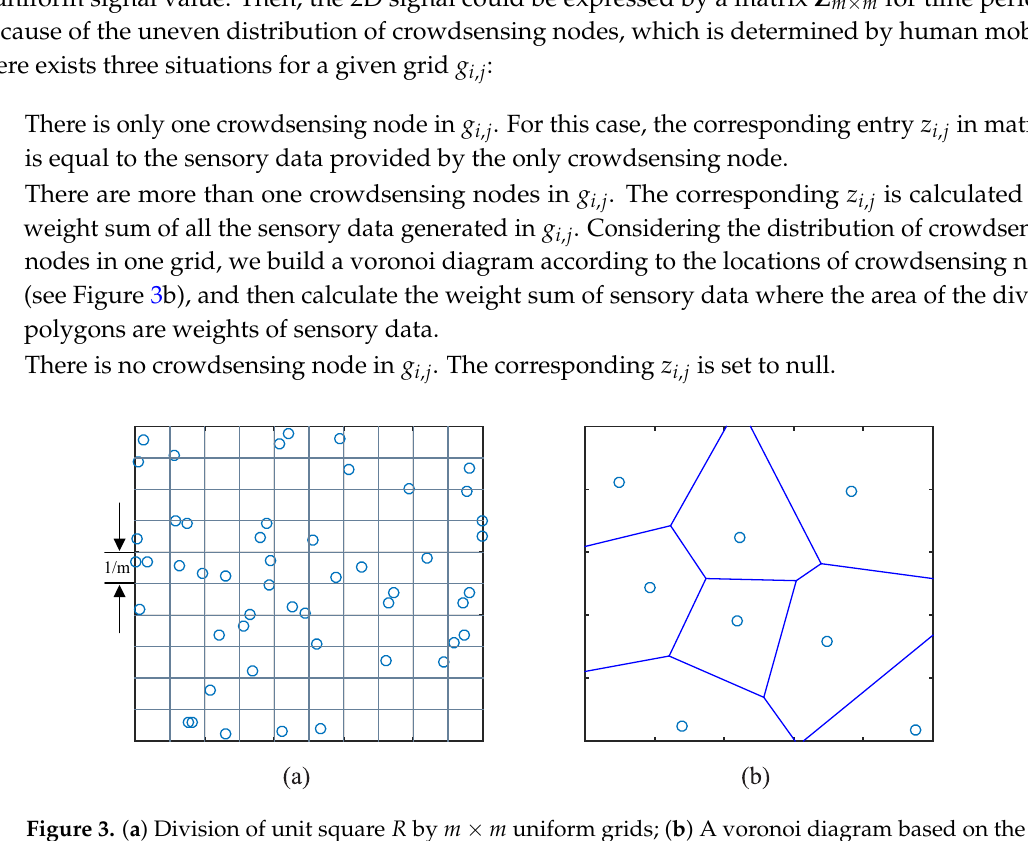
Figure 3. ( a ) Division of unit square R by m × m uniform grids; ( b ) A voronoi diagram based on the locations of crowdsensing